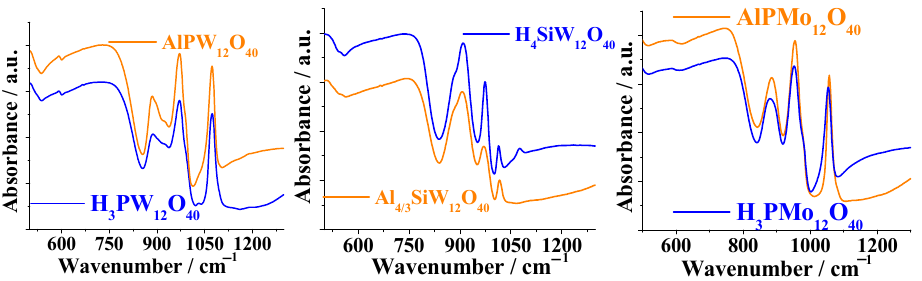
Figure 3. Infrared spectra of phosphotungstic, silicotungstic, and phosphomolybdic acids and their aluminium-exchanged salts (adapted from refs. [34,35]).